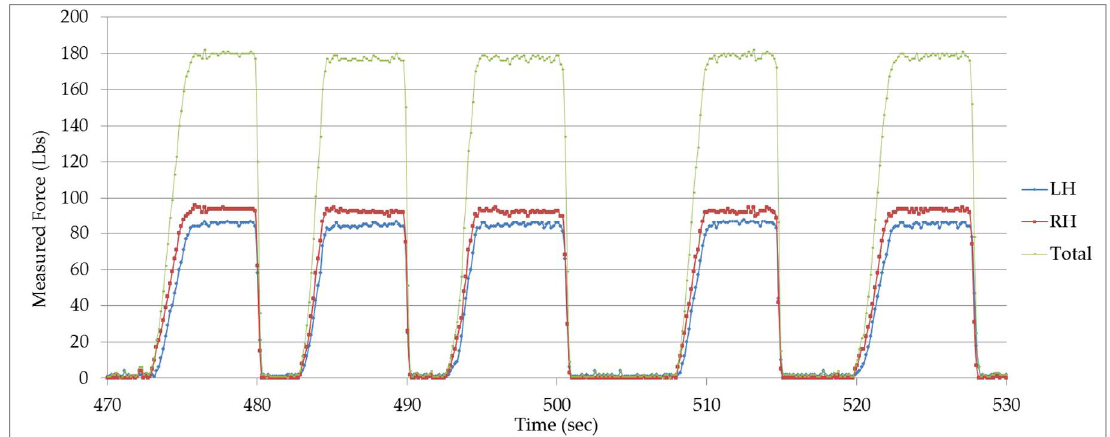
Figure 5. Athlete 2, set 3 indicating the exertion variance between left (LH) and right (RH) hands.